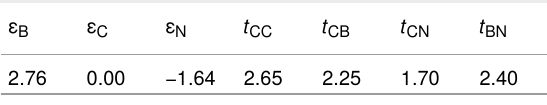
Table 1: Tight-binding parameters for the CBN composite structure a .